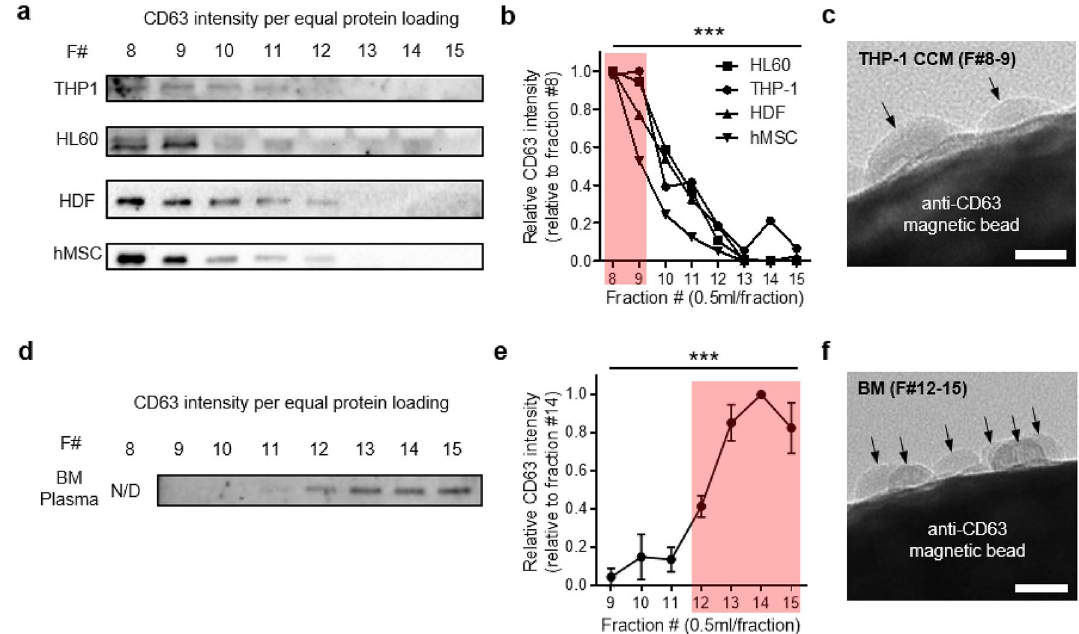
Figure 1. CD63 purity distributions of cell culture media (CCM) and bone marrow (BM) plasma upon utilizing CL-2B columns ( a ) Western blot analysis (equal protein loading) of CD63 on eluate fractions 8–15 of AML associated (THP-1 and HL60) and control (HDF and hMSC) cell lines. ( b ) Relative CD63 intensities of ( a ). ( c ) TEM image of anti-CD63 magnetic bead-labelled EVs collected in eluate fractions 8–9 (THP-1). EVs are marked with black arrows. Scale bar: 30 nm. ( d ) Western blot (equal protein loading) analysis of CD63 on eluate fractions 8–15 of BM plasma. N/D: Not Detectable. ( e ) Relative CD63 intensities of ( d ). ( f ) TEM image